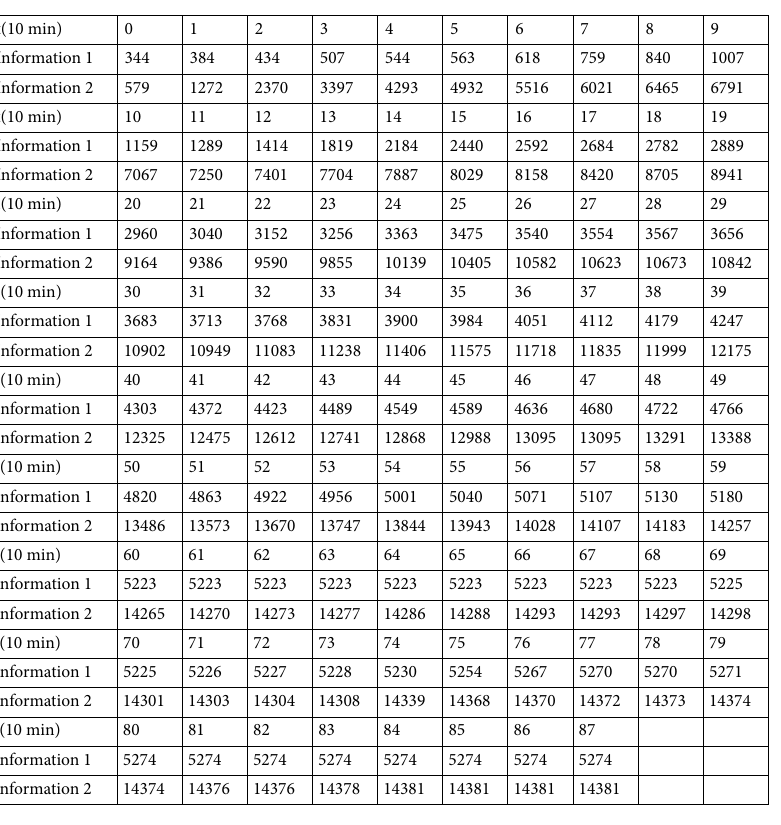
Table 3. Two cumulative forwarding number of public hot event 2-“A man beat up a girl in the street”, Jun.25th, 2019. On the streets of Dalian, Wu, the victim, was beaten by a man on her way home at night. At 1:06 p.m., information 1 about where the event occurred posted by @ TheBeijingnews burst slowly, after a short period, information 2 bursting with a great attention posted by @ Thepaper was that police did not get a call after the incident.